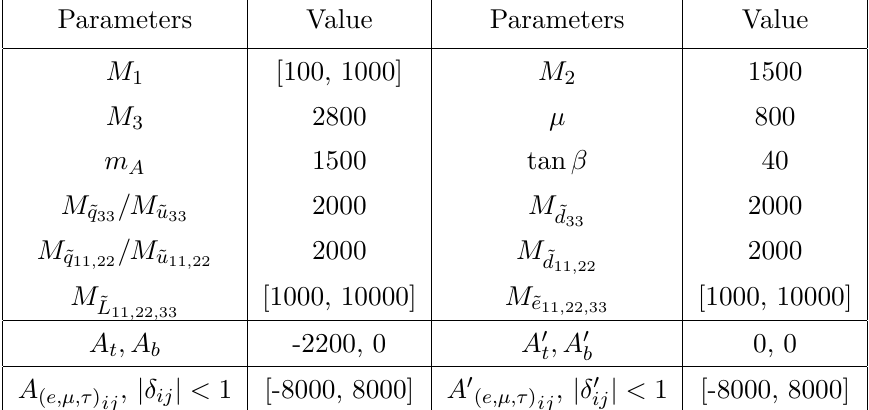
over broad range of values (see table e ij